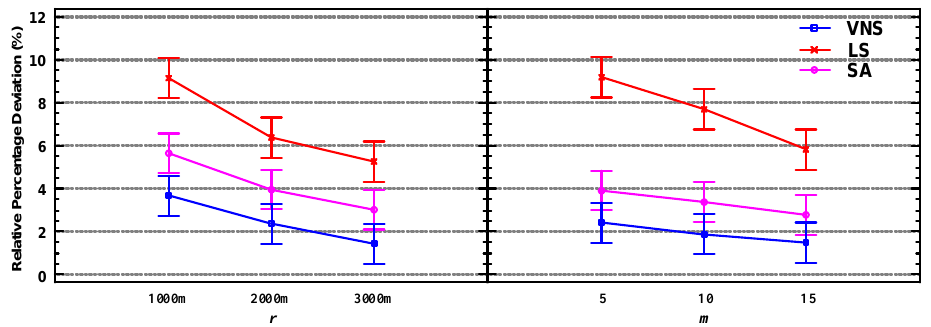
Figure 5. Interactions between area-related parameters with 95.0% Tukey HSD intervals.